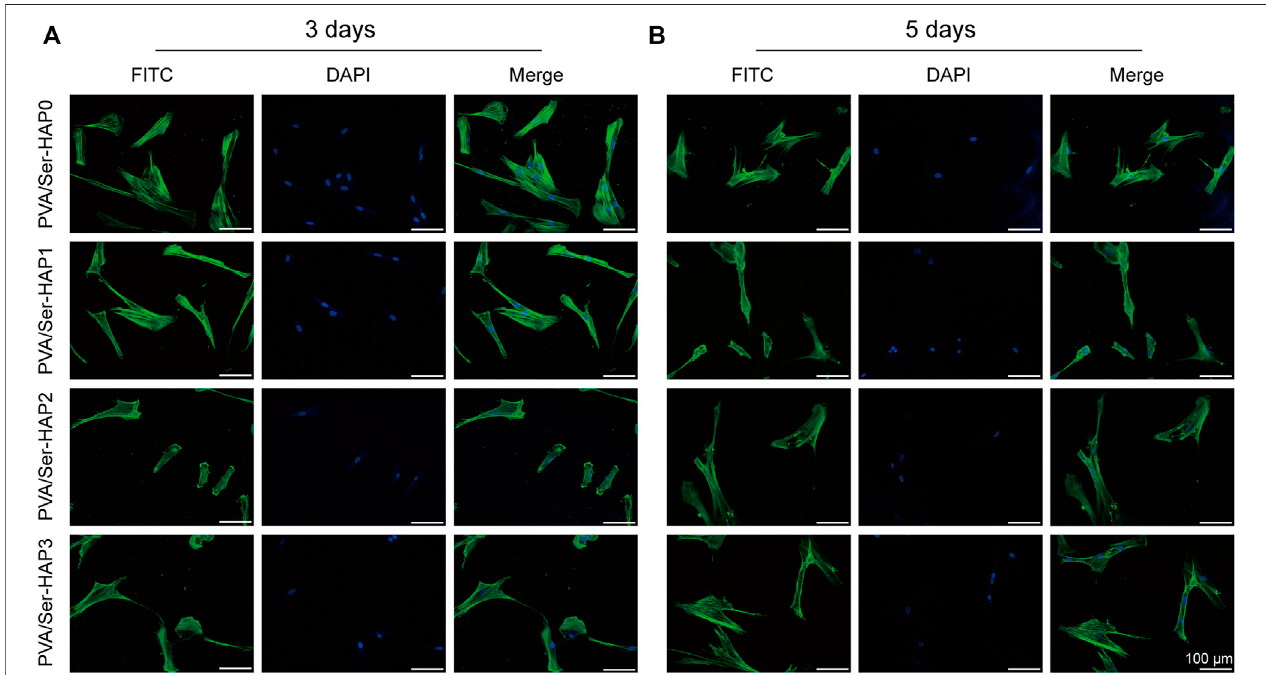
FIGURE 7 | Morphology of hPDLSCs after seeding on PVA/Ser-HAP membranes for 3 days (A) and 5 days (B) . Green, cytoskeleton stained with phalloidin; Blue, nuclei stained with